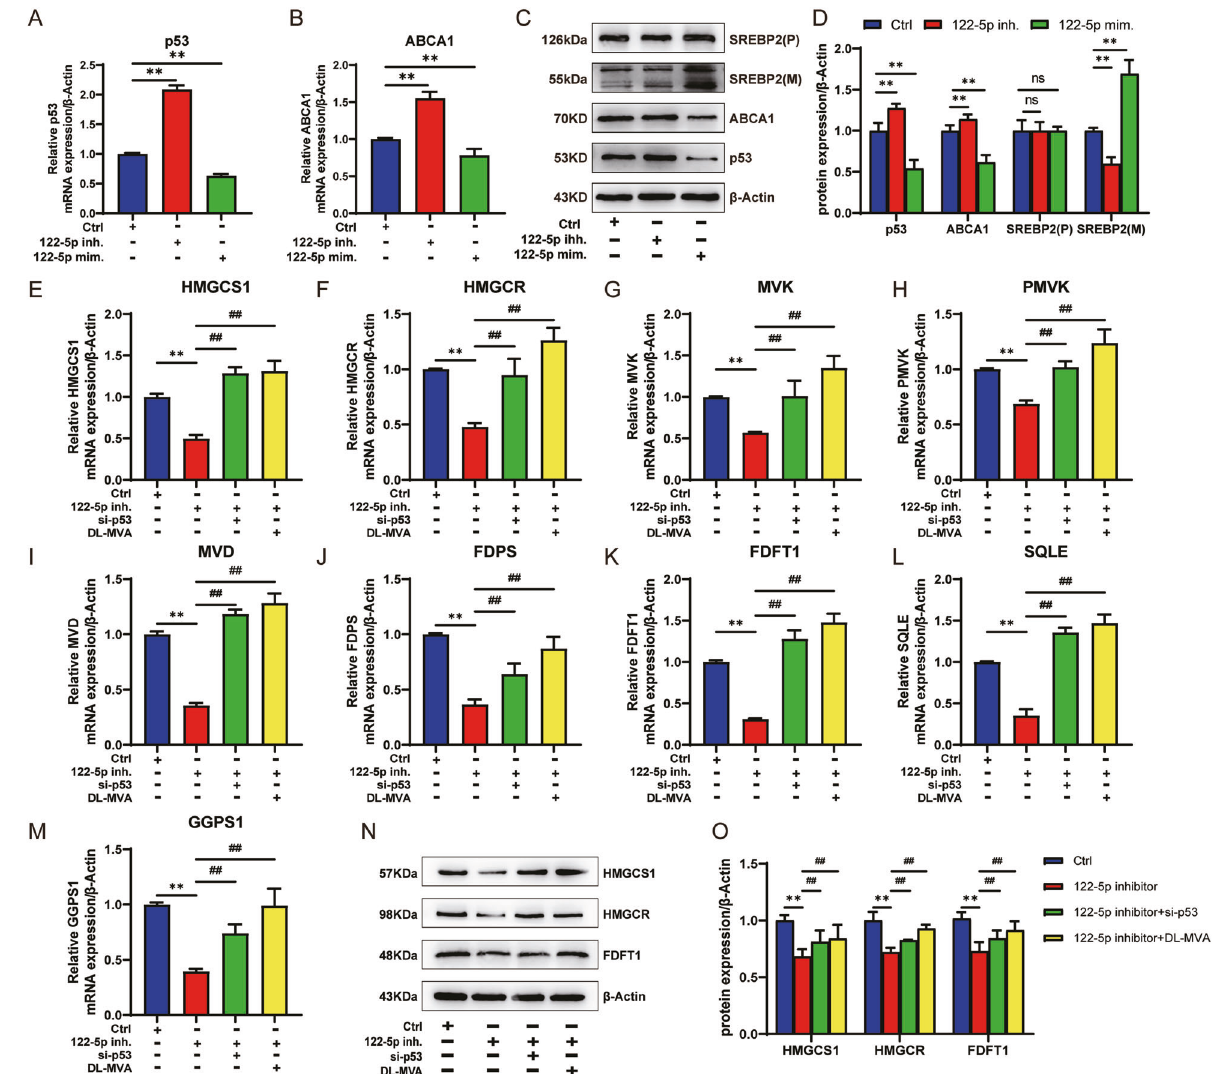
Fig. 3 Effect of miR-122-5p on the regulation of the MVA pathway by targeting p53. A549 cells treated with 122-5p inh. or 122-5p mim. and the relative mRNA expression of p53 ( A ) and ABCA1 ( B ) by RT-qPCR. p53, ABCA1, SREBP2(P), and SREBP2(M) protein expression using western blotting ( C ) and the bar graph corresponding to C after statistical analysis ( D ) in A549 cells treated with 122-5p inh. or 122-5p mim. and relative mRNA expression of the MVA pathway genes HMGCS1( E ), HMGCR ( F ), MVK ( G ), PMVK ( H ), MVD ( I ), FDPS ( J ), FDFT1 ( K ), SQLE ( L ), and GGPS1 ( M ) by RT-qPCR in A549 cells treated with 122-5p inh. combined with si-p53 or 122-5p inh. combined with DL-MVA or 122-5p inh. alone. The expression of the MVA pathway key proteins HMGCS1, HMGCR, and FDFT1 using western blotting ( N ) and the bar graph corresponding to N ( O ) in A549 cells treated with 122-5p inh. combined with si-p53 or 122-5p inh. alone. The above bar graphs were the sum of three independent experiments (mean ± SD). The ctrl group was A549 cells treated with a medium solution containing 122-5p inh. NC and si-p53 NC and DMSO, ns not signi fi cant, * P < 0.05 and ** P < 0.01 vs . Ctrl group, # P < 0.05 and ## P < 0.01 vs. 122-5p inh.